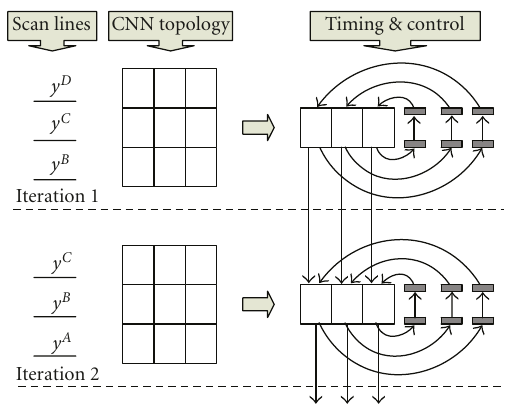
Figure 2: A pipelined CNN architecture with a pipeline three